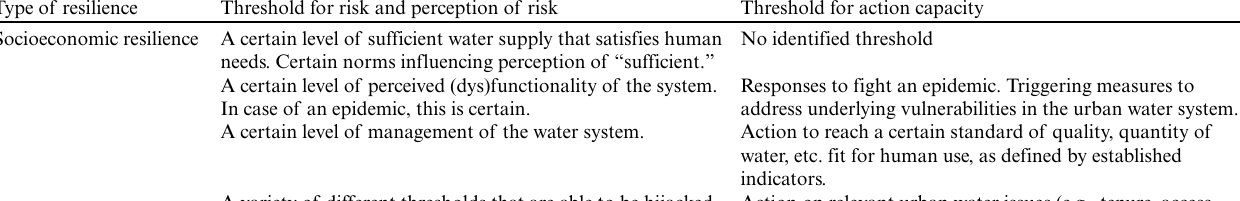
Table 2 . A summary of the two types of thresholds for the different levels of resilience identified from the empirical data: (1) the threshold for risk and perception of risk and (2) the threshold for action capacity that enables implementing measures and reorganization. Type of resilience Threshold for risk and perception of risk Threshold for action capacity No identified